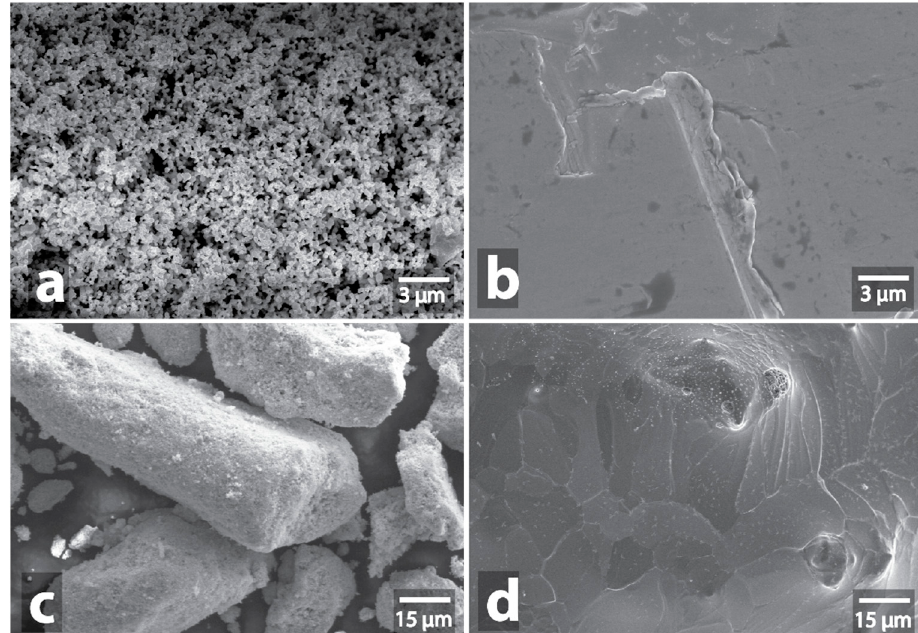
Figure 4. SEM image of initial Ag powder ( a ) and SEM image of Ag powder after MW-treatment ( b ), initial Pt powder ( c ) and SEM image of Pt powder after MW-treatment ( d ).